Question: What direction does the quantity move in — increasing or decreasing?
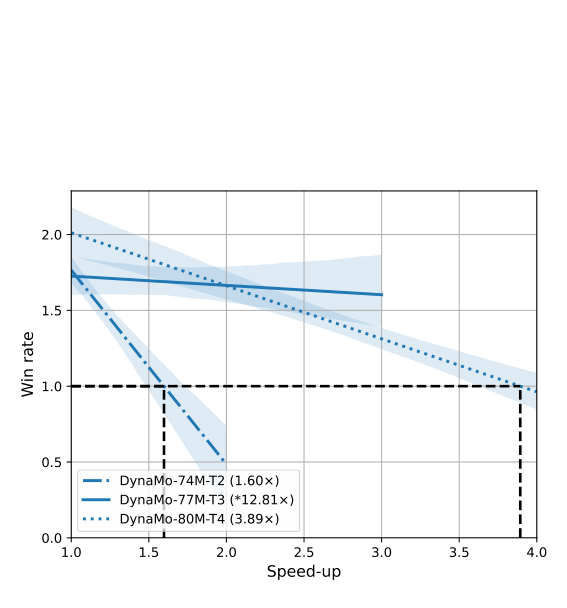
Answer: increasing